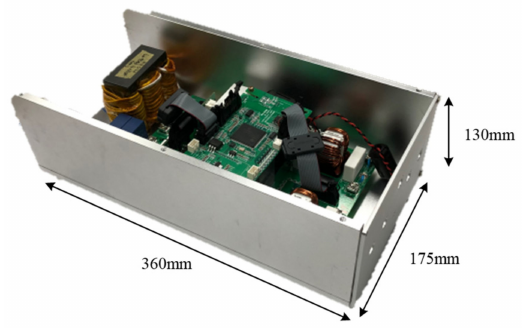
Figure 13. Prototype of the proposed 6.25 kW DBLLC resonant